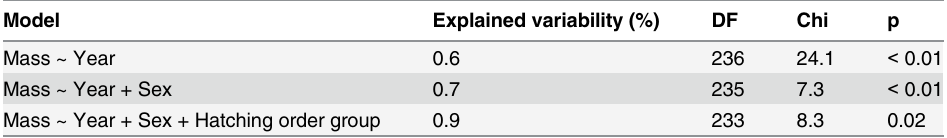
Table 2. Effects of the tested factors on nestling body mass, based on Gaussian GLMM models with nestling age as covariate and nestling individual and nest as random factors (n = 137 nestlings from 43 broods). Explained variability is shown in cumulative